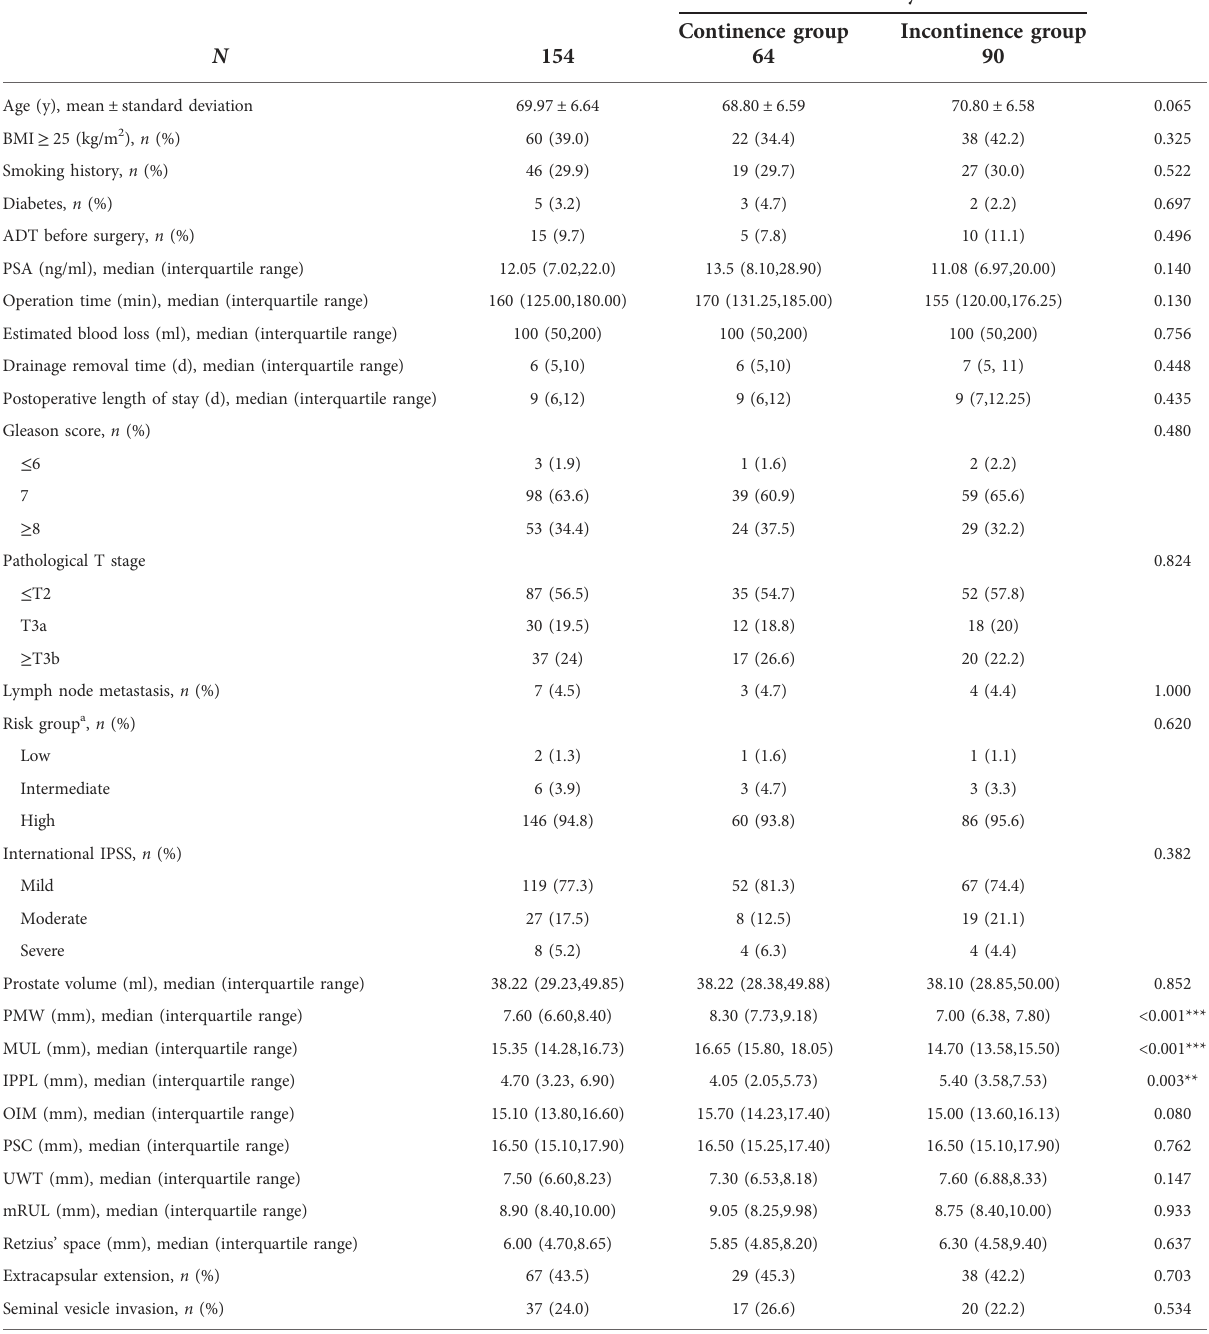
TABLE 1 Association between recovery of immediate urinary continence and perioperative